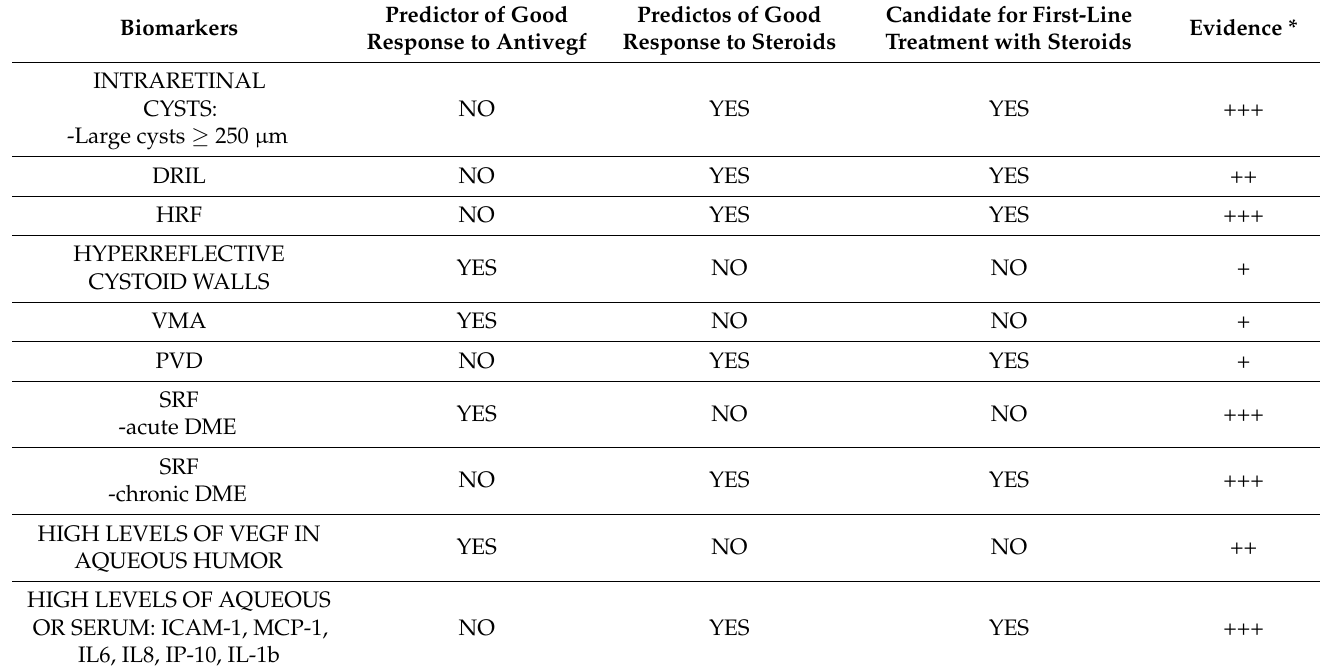
Table A1. Summary of biomarkers.